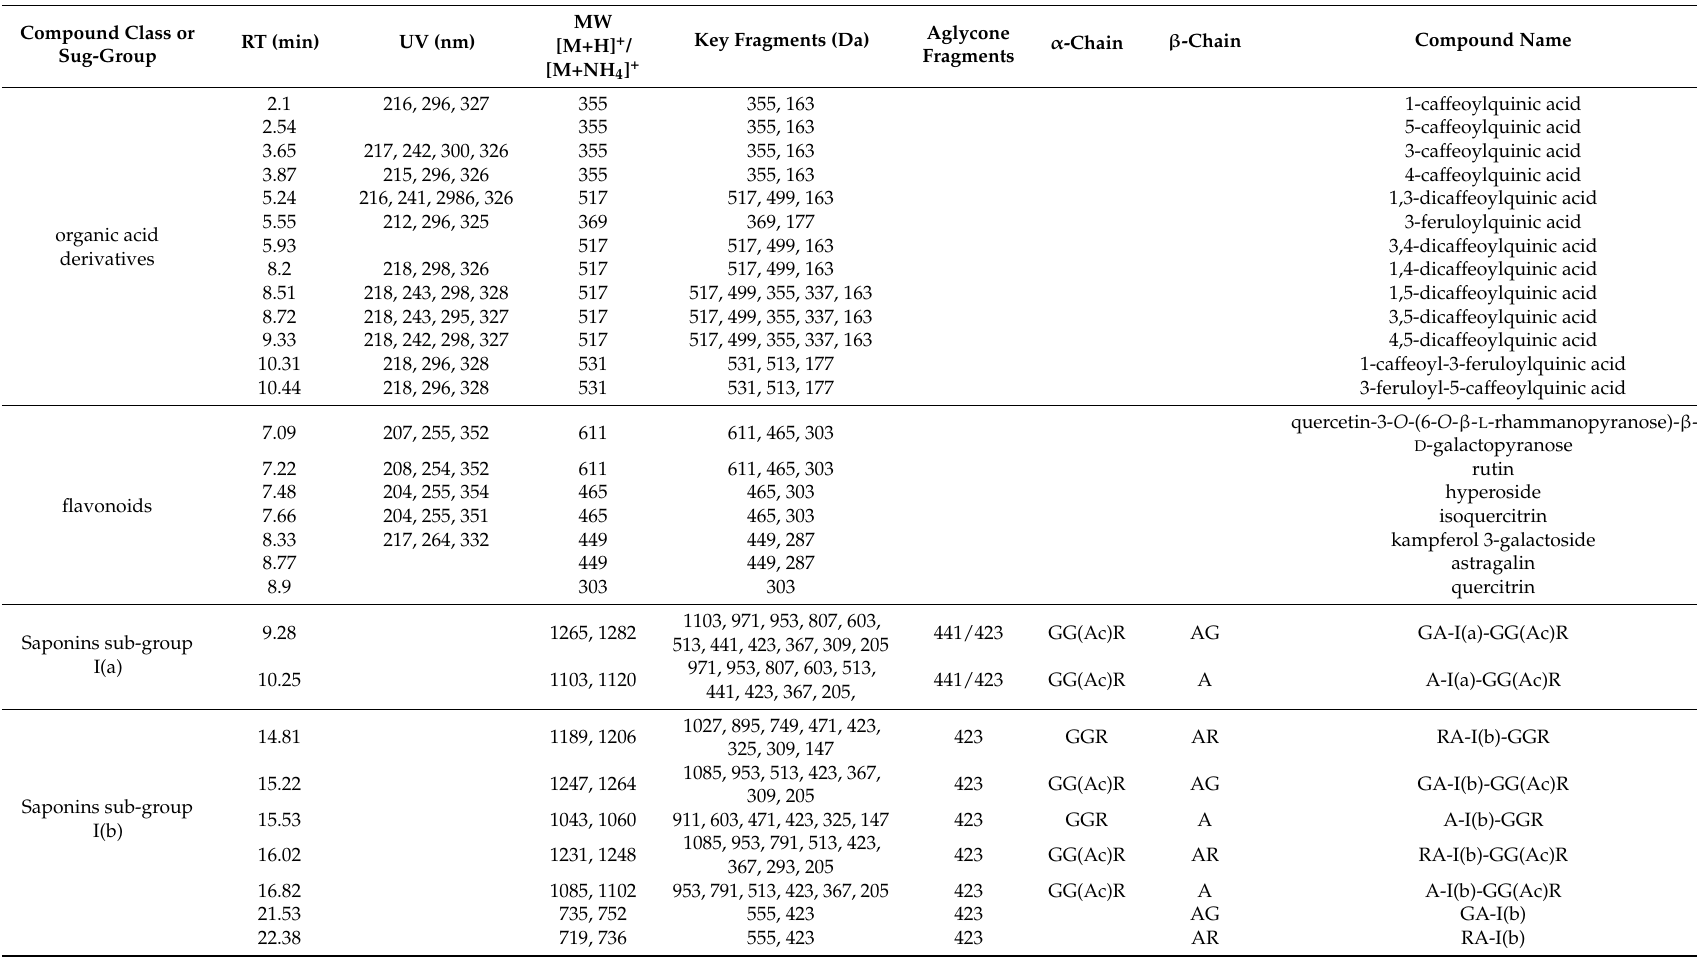
Table 1. Organic acid derivatives, flavonoids, and triterpene saponins identified from authentic E. senticosus